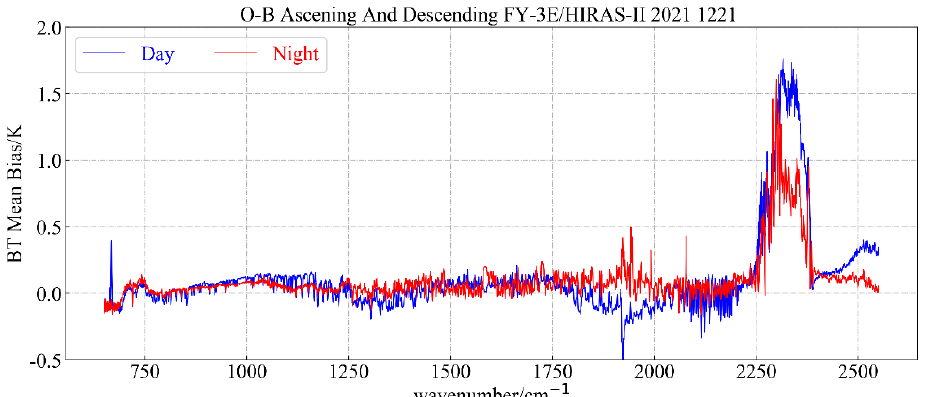
Figure 23. Comparison of the bias between the ascending and descending orbit during the day and night.